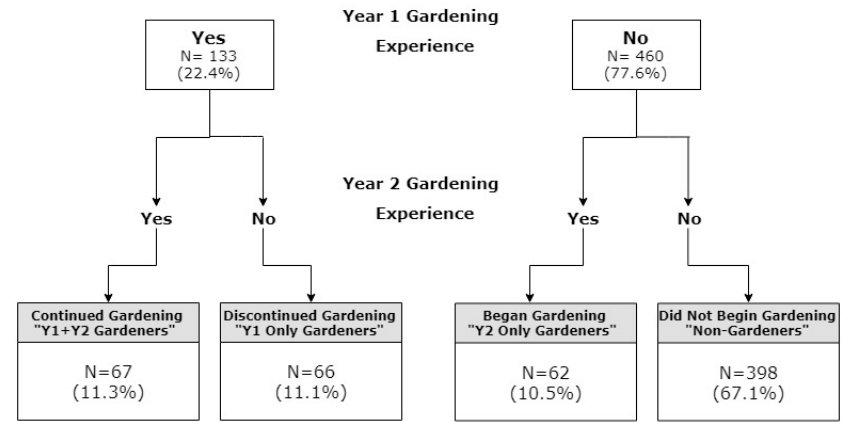
Figure 2. Overview of gardening experiences during the first two years of college. Students reported experiences with gardening in the previous 12 months at both year one (Y1) and Y2. Students were then grouped into one of four categories by their cumulative gardening experience over the two-year period.